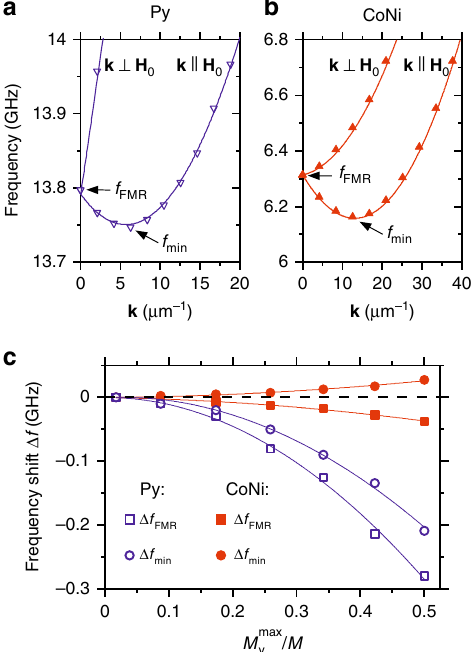
Fig. 4 Calculated spin-wave dispersion spectra. a , b Dispersion spectra for the Py and CoNi fi lms, respectively, calculated in the small-amplitude linear regime. f FMR and f min label the frequencies of the quasi-uniform FMR and of the lowest-frequency spin-wave mode, respectively. Symbols are the results of micromagnetic simulations, curves — calculations based on the analytical theory. c Dependences of the characteristic frequencies f FMR and f min on the normalized precession amplitude. Symbols are the results of micromagnetic simulations, curves — guides for the eye. All calculations were performed at H 0 = 2.0